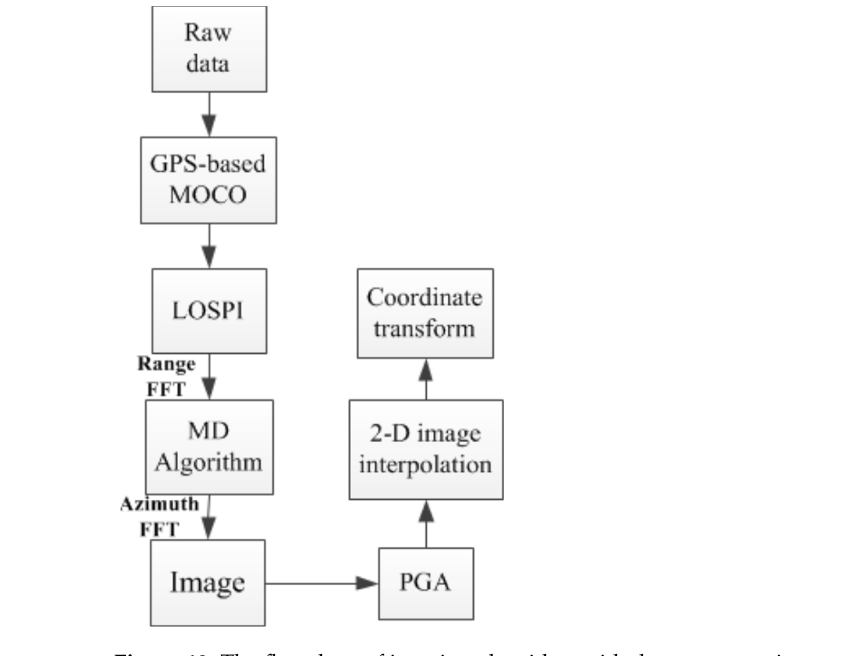
Figure 10. The flowchart of imaging algorithm with three-step motion compensation.